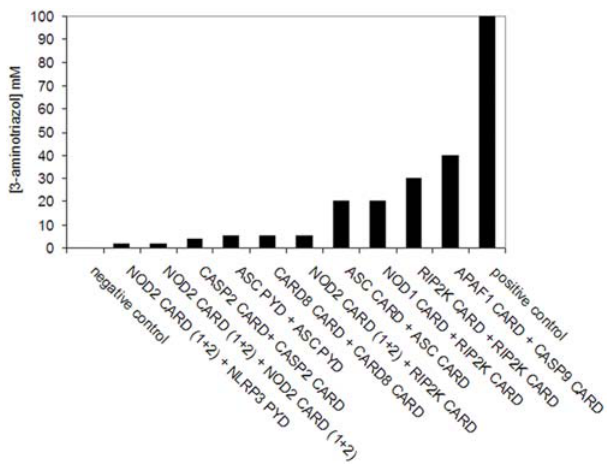
Figure 2. Strength of selected interactions in terms of HIS3 reporter gene activation. The maximum concentration of 3- aminotrizol supporting visible growth of transformants is indicated.